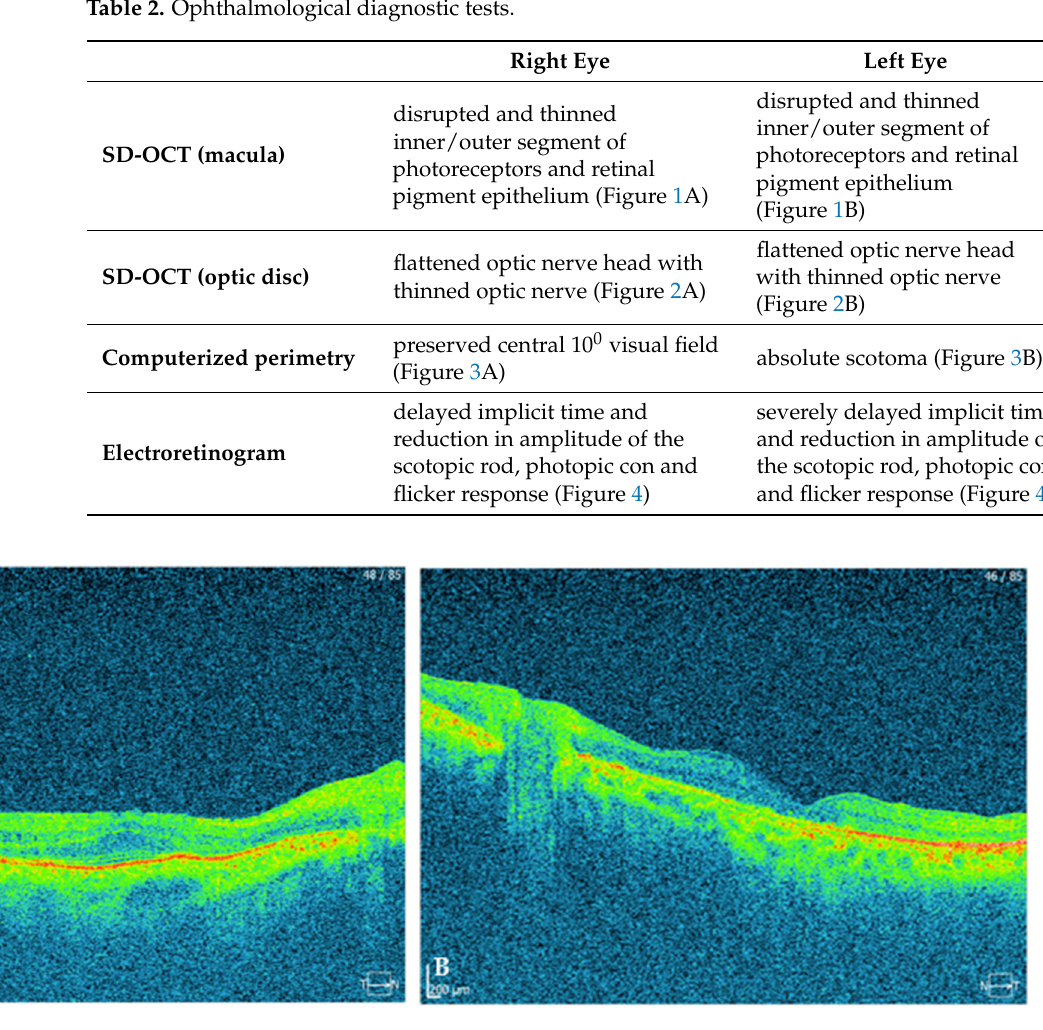
Figure 2. ( A ) SD-OCT image of the optic disc of the right eye; ( B ) SD-OCT image of the optic disc of the left eye. Figure 3. ( A ) Visual field of the right eye; ( B ) visual field of the left eye.